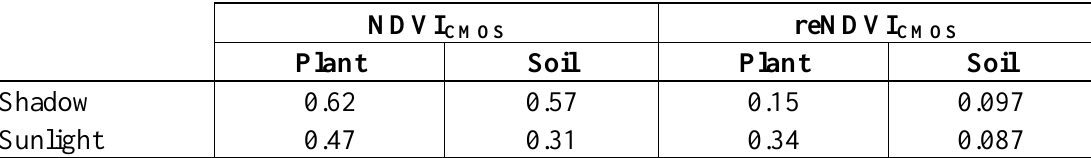
Table 1. NDVI and reNDVI results for 10 by 10 averaged pixel values in a range CMOS CMOS from 0 to 1. The regions where taken out of the red squares in Figure